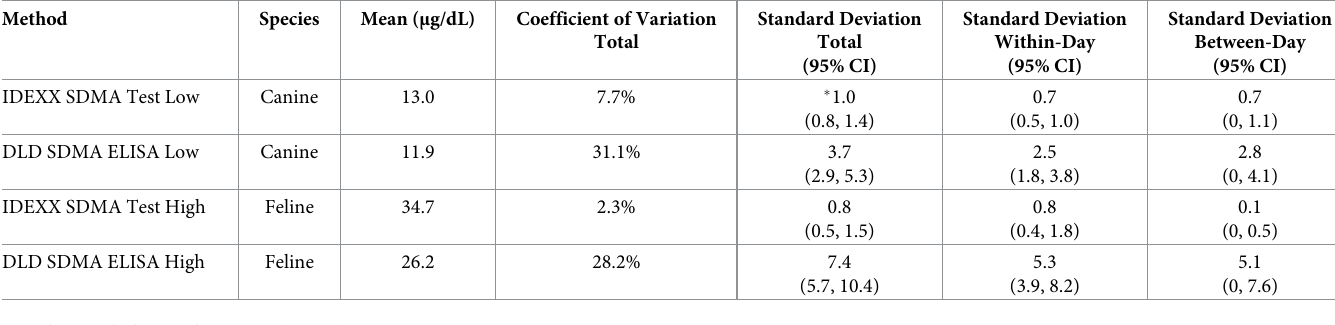
Table 3. Variation by assay for each pooled serum